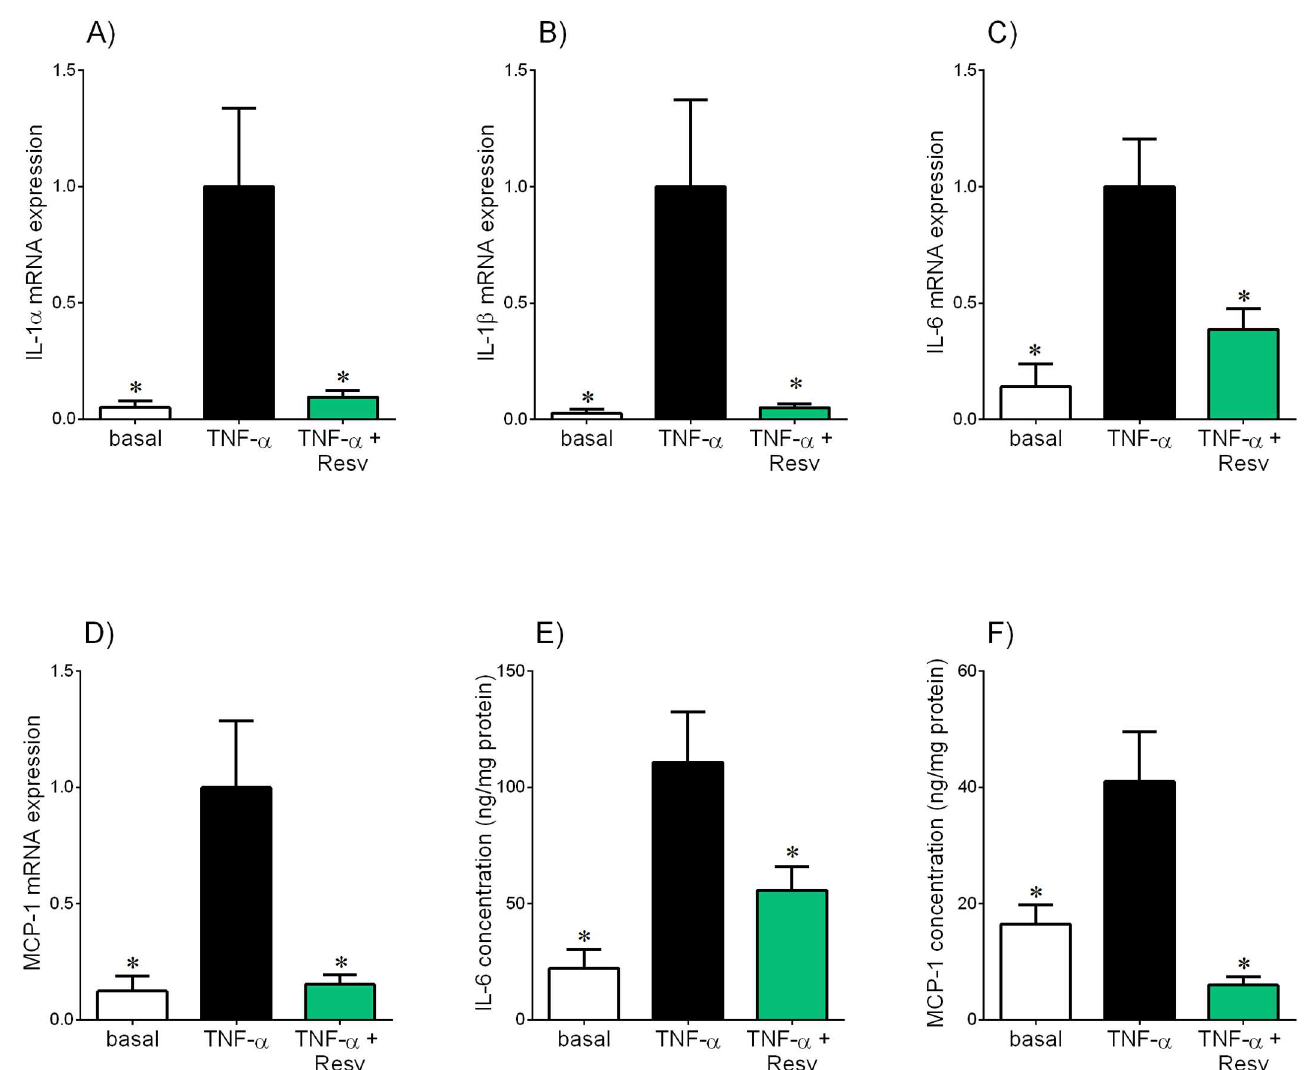
Fig 4. Effect of resveratrol on TNF- α -induced pro-inflammatory cytokines and chemokines in omental adipose tissue. Human omental adiposetissue was incubatedwith 10 ng/ml TNF- α in the absence or presenceof 200 μ M resveratrol (resv) for 20 h (n = 6 patients). (A-D) IL-1 α , IL- 1 β , IL-6 and MCP-1 mRNA expressionwas analysedby qRT-PCR and the fold changewas calculatedrelative to TNF- α . (E,F) The incubation medium was assayed for concentration of IL-6 and MCP-1 releaseby ELISA. All data are displayedas mean ± SEM. * P < 0.05vs. TNF- α . doi:10.1371/journal.pone.0173373.g004 PLOS ONE | DOI:10.1371/journal.pone.0173373 March 9,